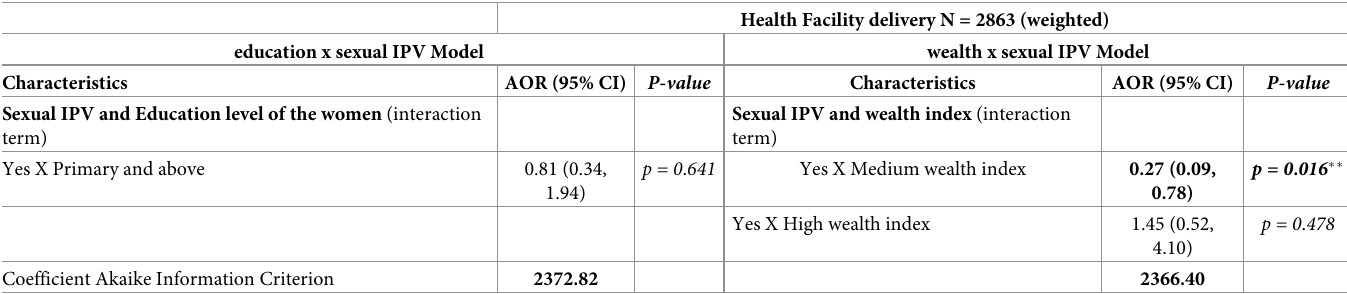
Table 4. Association between ever exposure to Sexual IPV, and utilization of health facility delivery and the moderating effect of education and